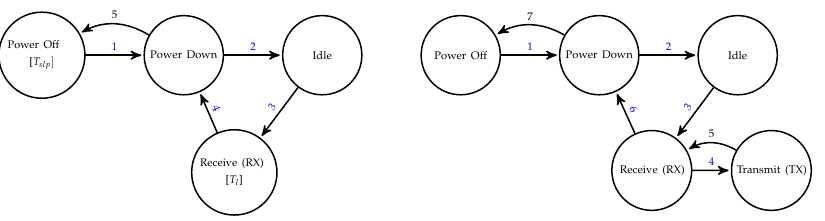
Figure 1. State transition diagrams of one CC2420 radio activation with no channel activity ( left ) and with channel activity ( right ). RX and Power Off states include also their durations, T l and T slp , respectively, on the figure on the